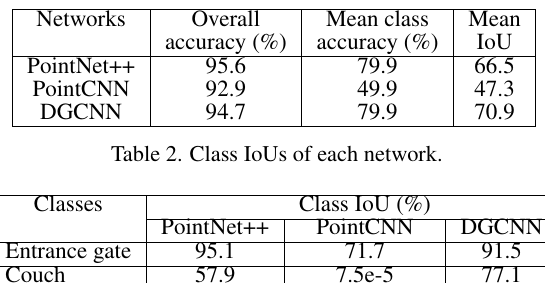
Table 1. Results on different networks.